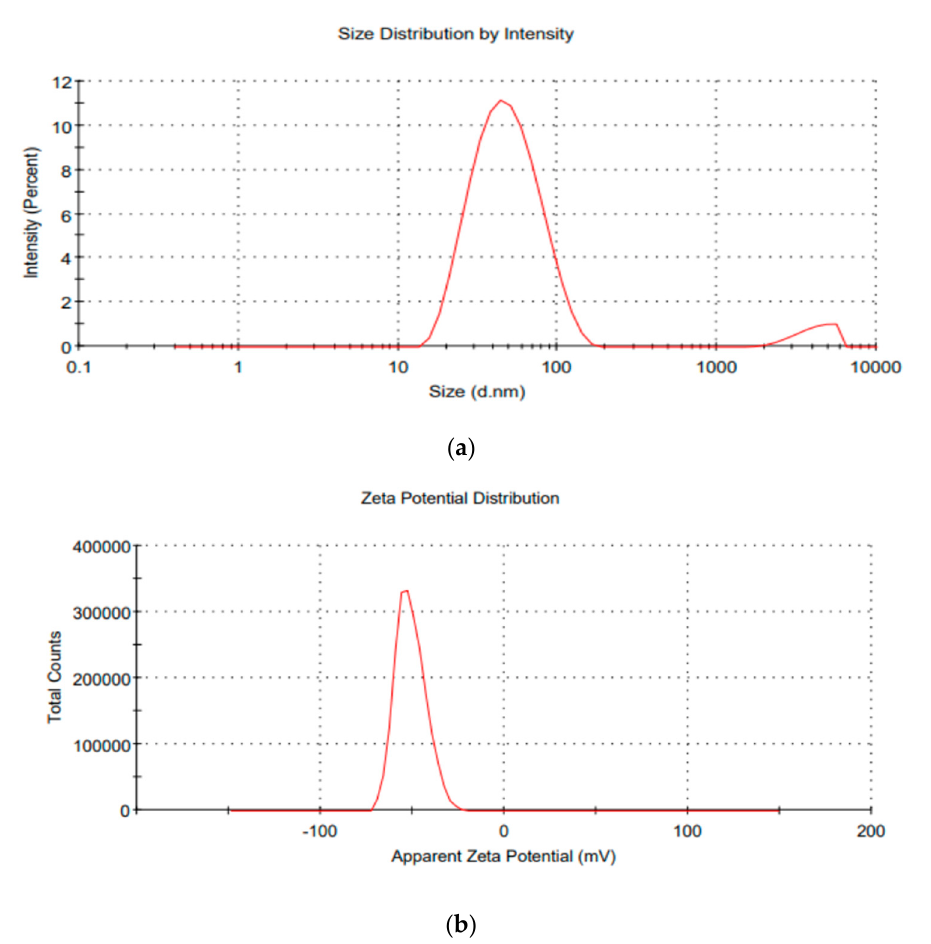
Figure 1. ( a ) Graphical view of the size, PDI properties. ( b ) Zeta potential of optimized VLT-ETH formulation. PDI, polydispersity index; VLT, valsartan; ETHs, ethosomes. Table 6. The actual values of the optimized VT-ETH